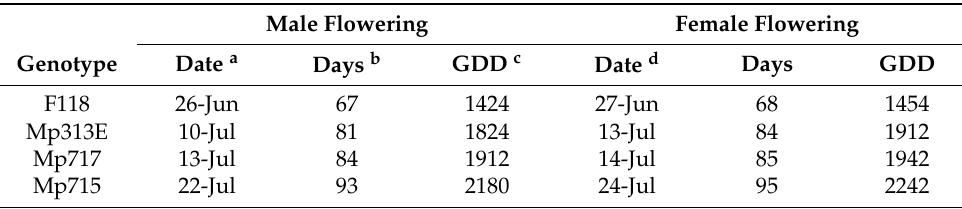
Table 8. Relative days to flowering of four inbred lines planted in summer nursery rows at Mississippi State, MS on 20 April